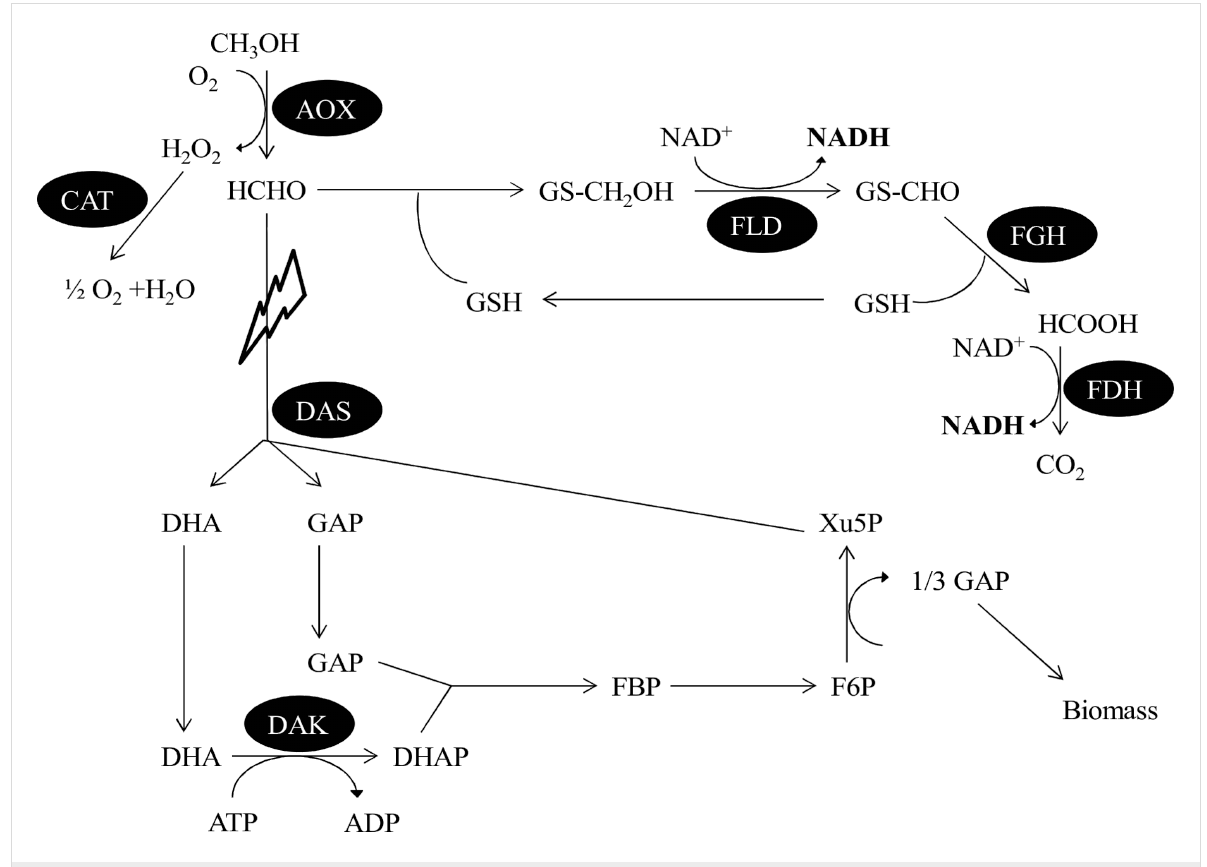
Figure 1: Simplified schematic representation of the methanol utilization pathway in Pichia pastoris . The main pathways and the respective enzymes are shown. AOX: alcohol oxidase; FLD: glutathione-dependent formaldehyde dehydrogenase; FGH: S -formylglutathione hydrolase; FDH: formate dehydrogenase; CAT: catalase; DAS: dihydroxyacetone synthase; DAK: dihydroxyacetone kinase; DHA: dihydroxyacetone; GAP: D-glyceraldehyde- 3-phosphate; DHAP: dihydroxyacetone phosphate; FBP: D-fructose 1,6-bisphosphate; F6P: D-fructose 6-phosphate; Xu5P: D-xylulose